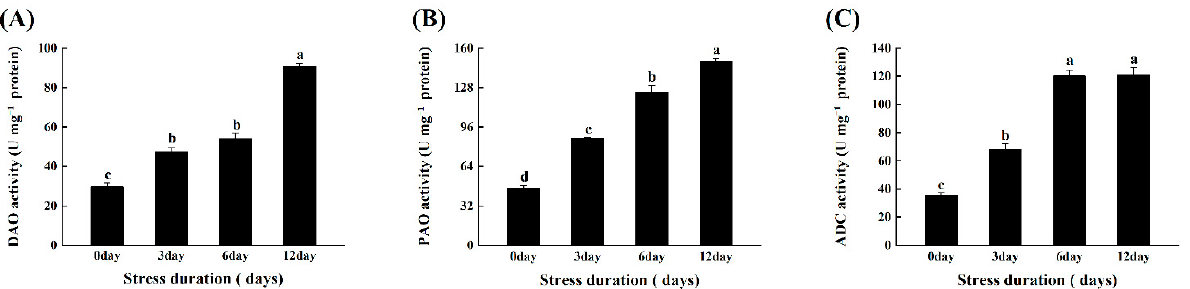
Figure 8. Effects of salt stress on ( A ) Diamine oxidase (ADC); ( B ) polyamine oxidase (PAO); and ( C ) Arginine decarboxylase (ADC) in tomato leaves grown for 12 days under control and salt stress. Values are mean ± SD (Standard Deviation) of three replications. Different letters indicate significant differences at p ≤ 0.05 (Tukey’s HSD test).